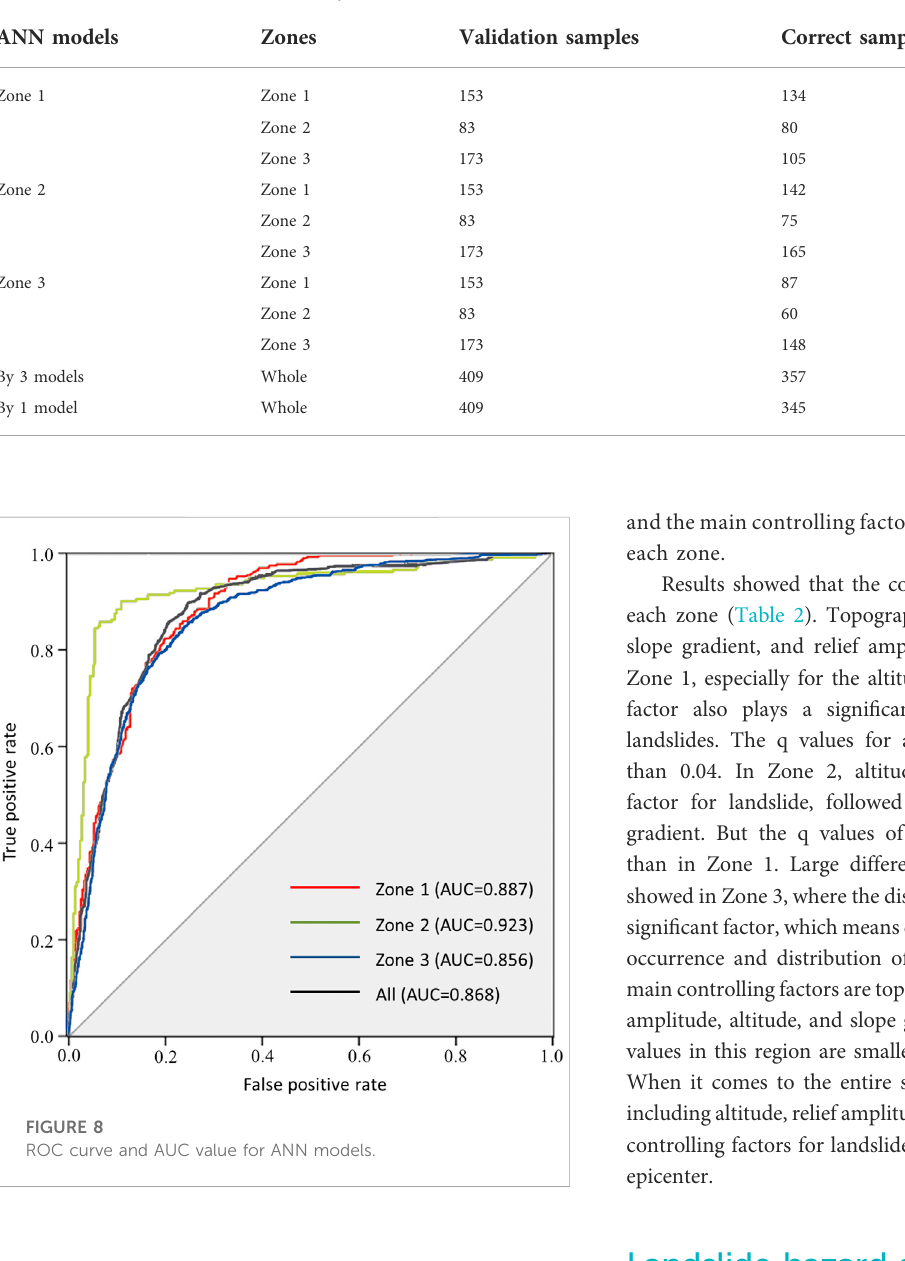
TABLE 3 Landslide hazard assessment maps validation.